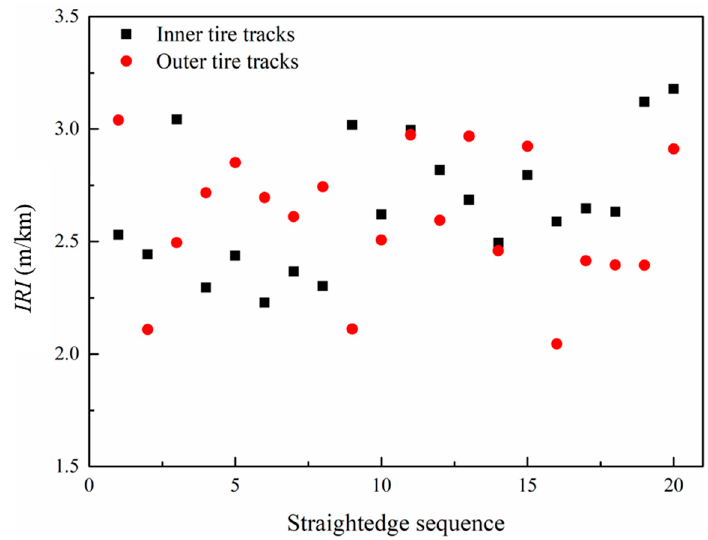
Figure 13. IRI Values.